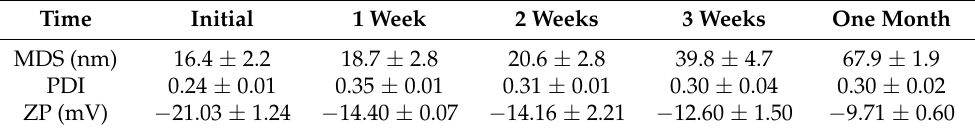
Table 4. Mean droplet size (MDS), polydispersity index (PDI), and zeta potential (ZP) of